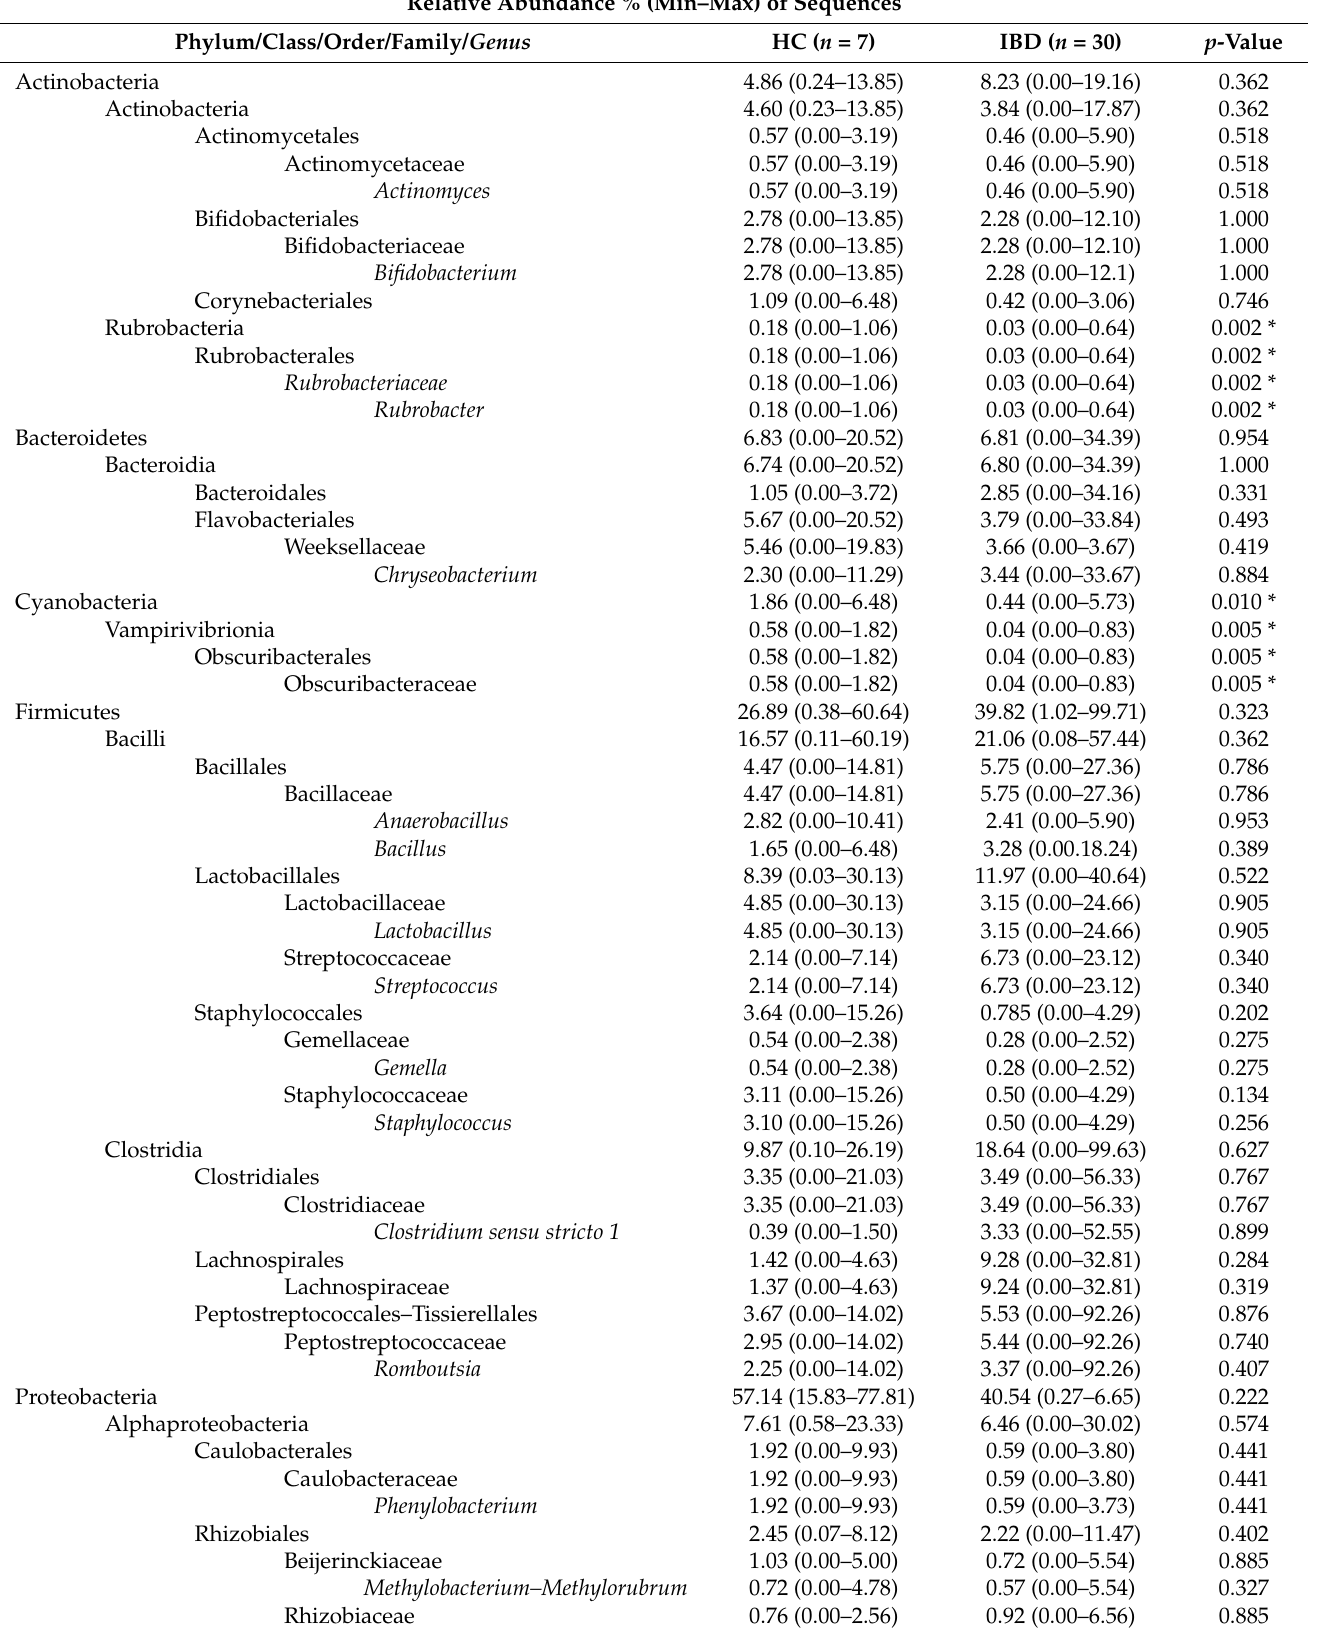
Table 3. Relative proportions of predominant bacterial taxa in the duodenal